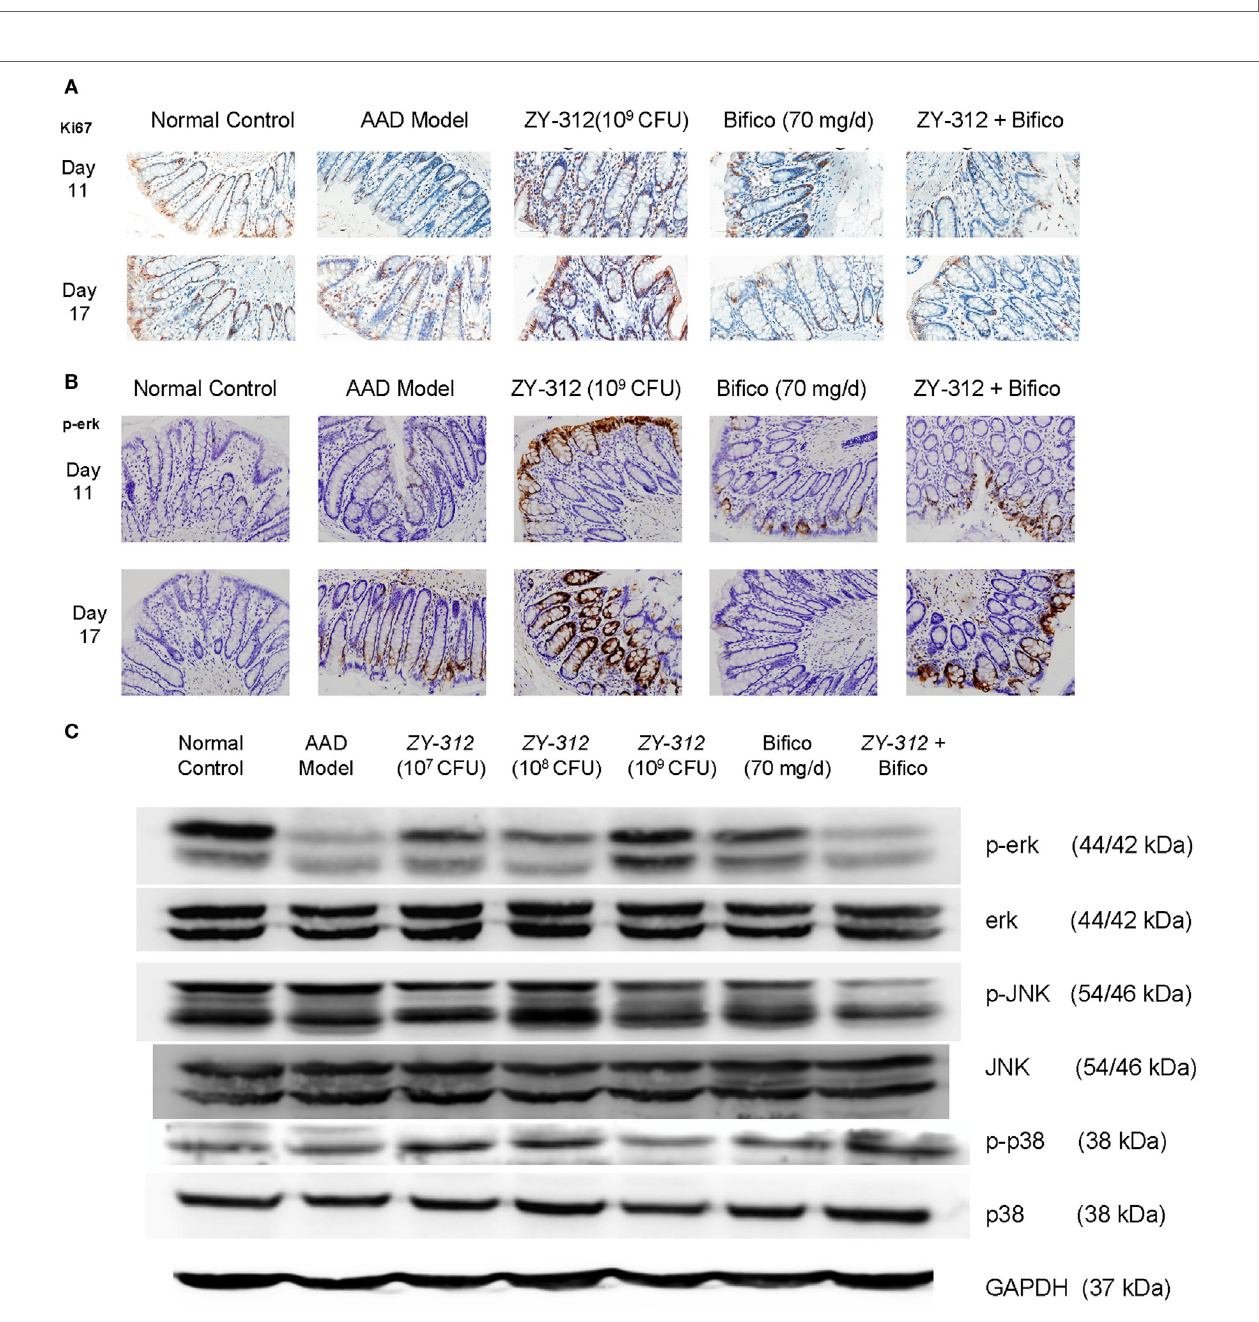
FigUre 5 | Bacteroides fragilis ZY-312 improves gut barrier integrity in antibiotic-associated diarrhea (AAD) rats. (a) Alcian blue staining for detecting goblet cells numbers were shown in normal rats, AAD rats treated with normal saline, ZY-312 [10 9 colony-forming units (CFU)], Bifico (70 mg/day), or Bifico (70 mg/day) combined with ZY-312 (10 8 CFU) on days 11 and 17. n = 8/group. (B) Immunohistochemistry of Muc2 protein located in colonic tissues was detected in all groups as mentioned above. (c) Immunofluorescence staining for ZO-1 and ZO-1 ( TJP1 ) mRNA level in all the groups was shown as mentioned above. The magnifications of the above figures are 10 × and 40 × . (D) Colon protein level and mRNA expression of occludin in all groups on days 11 and 17 were shown. (e) qPCR analysis of AQP1, AQP3, and AQP8 gene in colonic tissues were detected in all groups as indicated in Figure 3 , with mRNA fold changes normalized to those of normal control group. One-way ANOVA, * P < 0.05 and ** P < 0.01 versus AAD